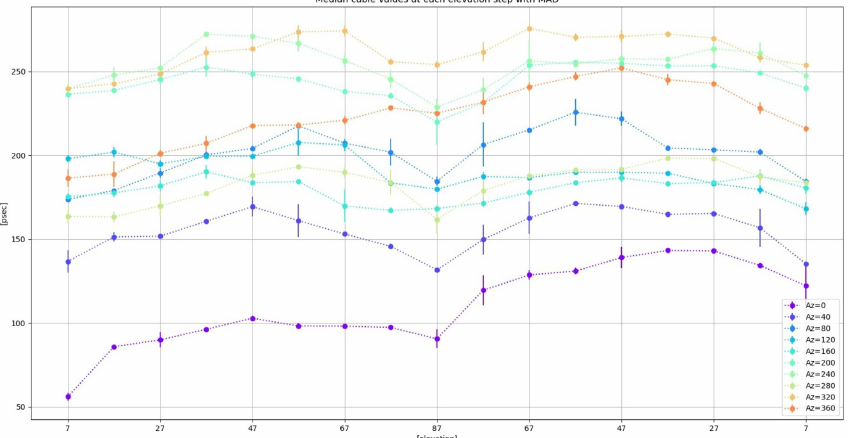
Figure 26. Median values of cable delay measurements at each elevation step for loops at different azimuths. The error bar represents the median absolute deviation (MAD).